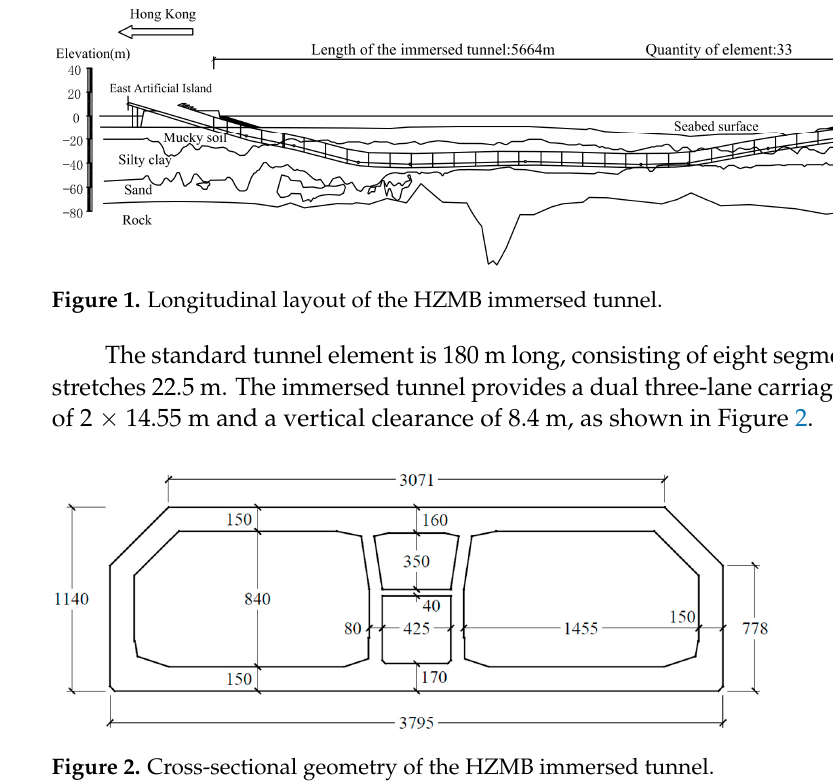
Figure 2. Cross-sectional geometry of the HZMB immersed tunnel.